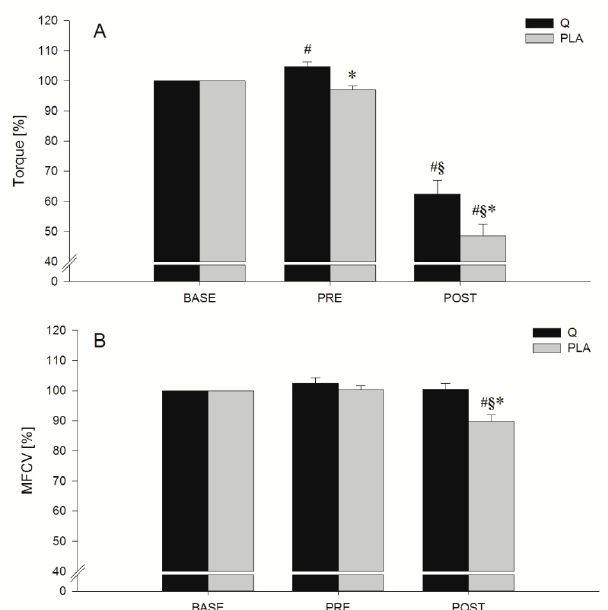
Figure 3. Mean torque and mean fiber conduction velocity (MFCV) values obtained during the maximal voluntary isometric contraction (MVIC) tests before (MVICPRE) and after (MVICPOST) the eccentric exercise in quercetin (Q; black bars) and placebo (PLA; grey bars) conditions. Data are expressed as a percentage of MVICBASE. #, §, * p < 0.05; significantly different from baseline (BASE), before (PRE) and Q respectively.